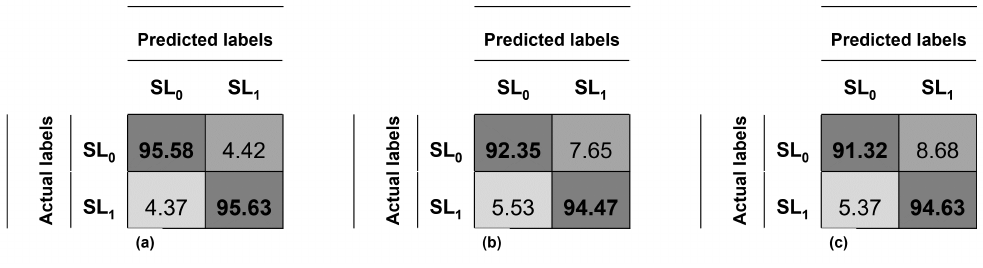
Figure 4. Confusion matrix of the detection of the palsy: ( a ) on the entire face, ( b ) on the eyes region and ( c ) on the mouth region.